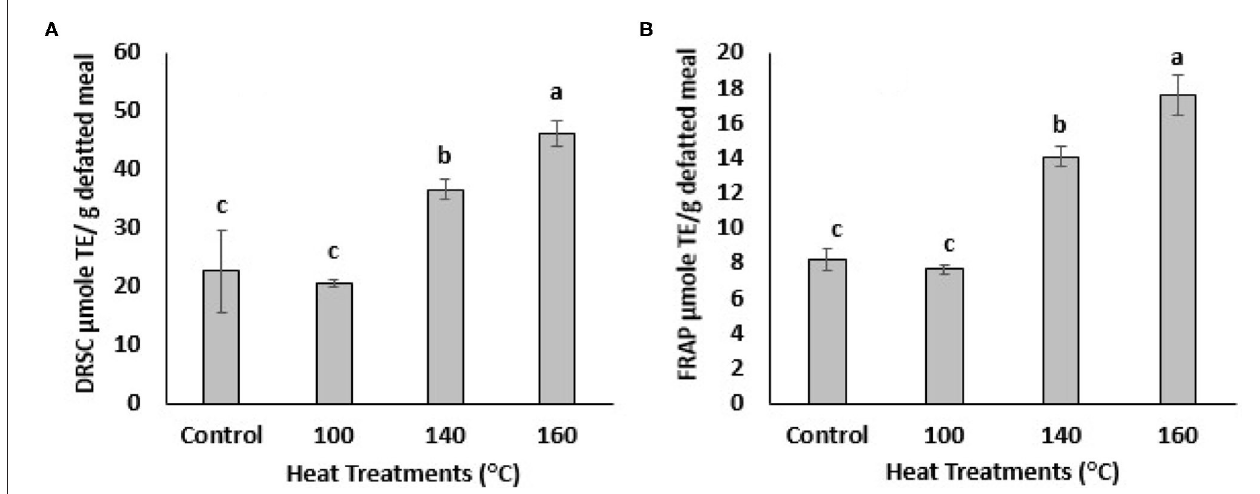
FIGURE 3 | DPPH radical scavenging capacity (DRSC, A ) and ferric-reducing antioxidant power (FRAP, B ) of extracts from defatted BSG meal affected by various oven heat treatments. Means followed by the same letters are not significantly different at p >